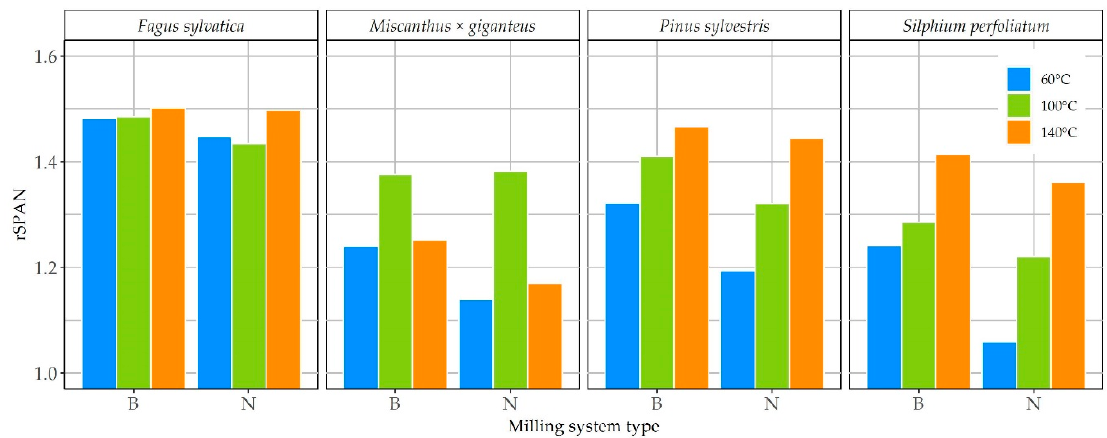
Figure 7. Ground materials’ rSPAN value, where B is the hammer milling system and N is the knife milling system. milling